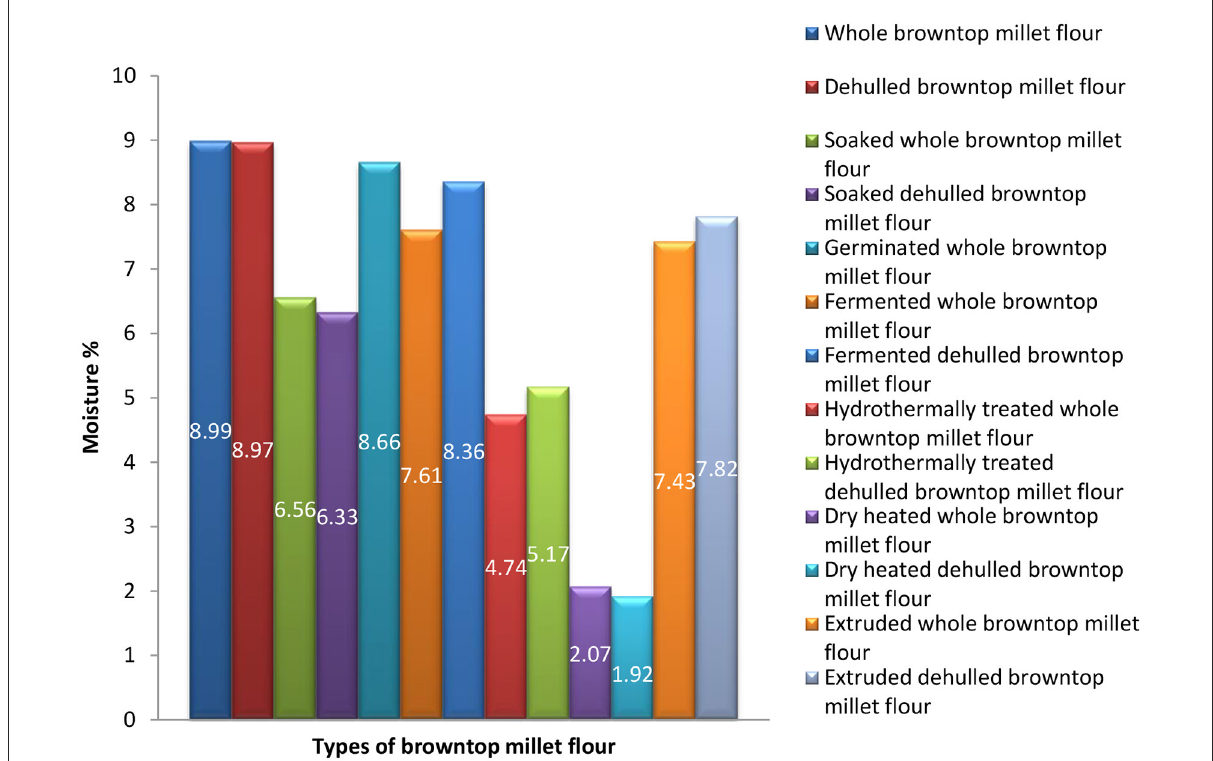
FIGURE2 Moisture content of differently processed browntop millet flour. Source: Sirisha et al. (2022).